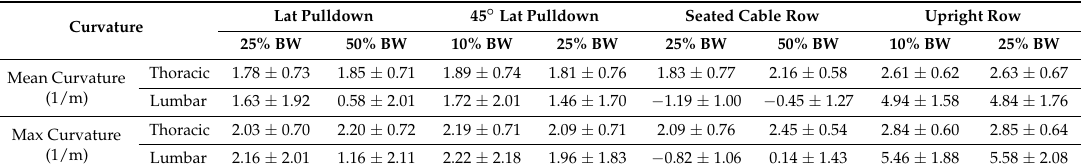
Table A3. P -values and ( χ 2 ) for the maximum, minimum and ROM of the curvature angles in the thoracic and lumbar regions, mean and standard deviation over all subjects—was not analysed. P -Values and ( χ 2 ) 45° Lat Pulldown